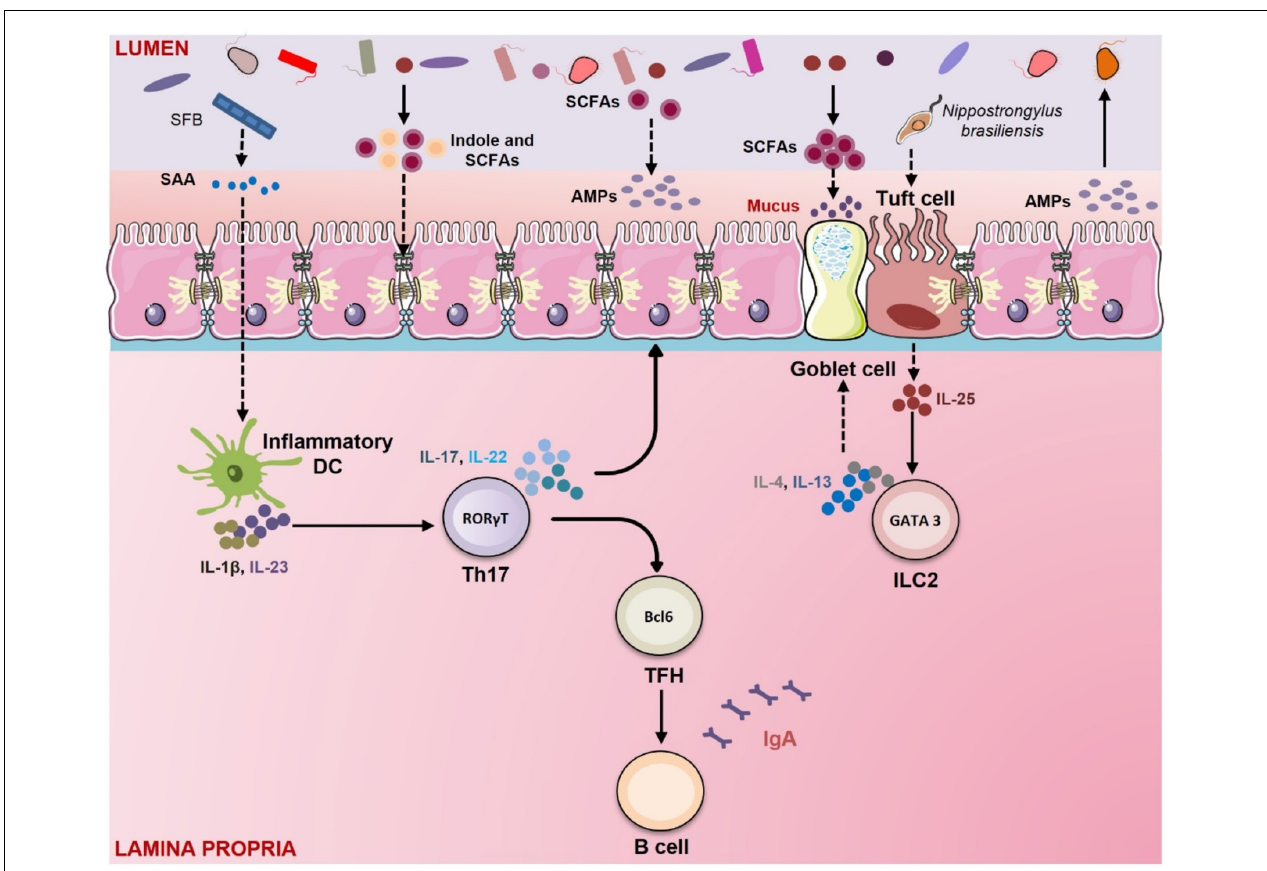
FIGURE 3 | Gut membrane integrity: Role of Gut Microbiota (GM) and immune system. GM has a crucial role in regulating gut permeability. GM maintains intestinal integrity via several mechanisms. In mice segmented filamentous bacteria (SFB) induce the secretion of serum amyloid A (SAA) from epithelial cells which further activates the dendritic cells to secrete IL-1 β and IL-23. IL-1 β and IL-23 promote the differentiation of Th17 cells which produce IL-17 and IL-22. These cytokines stimulate the epithelial cells to secrete antimicrobial peptides (AMPs). GM produces tryptophan metabolites like indole that enhance the expression of tight junction (TJ) proteins. Short-chain fatty acids (SCFAs) produced by GM promote the goblet cells to produce mucus. SCFAs such as butyrate also upregulate the expression of tight junction (TJ) proteins and induce the production of AMPs from epithelial cells. Parasites like Nippostrongylus brasiliensis promote the secretion of IL-25 from tuft cells. IL-25 stimulates the innate lymphoid cells (ILC)-2 to produce IL-4 and IL-13. These cytokines induce goblet cell hyperplasia and mucous